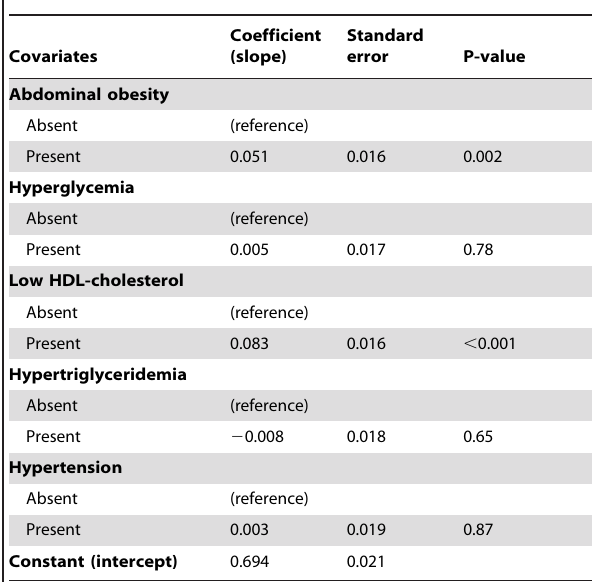
Table 2. Multivariate analysis of factors associated with serum lipopolysaccharide-binding protein (LBP) concentrations: demographic factors, lifestyle factors and body mass.